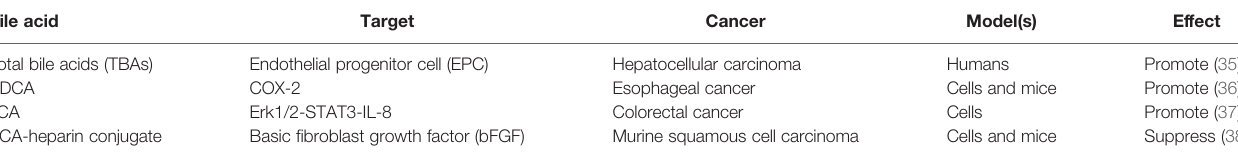
TABLE 1 | The impact of bile acid on cancer angiogenesis. Bile